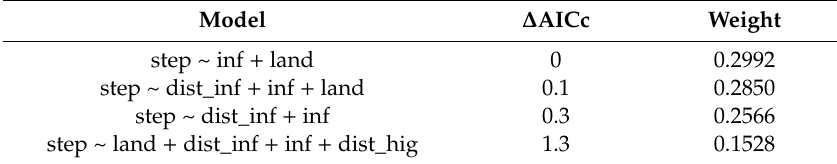
Table 1. Models that explained the step length of GLT groups. Step = step length; inf = type of linear infrastructure (highway, unpaved road, pipeline, and powerline); land = landscape features (native habitat (forest and regeneration areas), no habitat (pasture and linear infrastructures)); dist_inf = distance to the closest infrastructure; dist_hig = distance to the closest